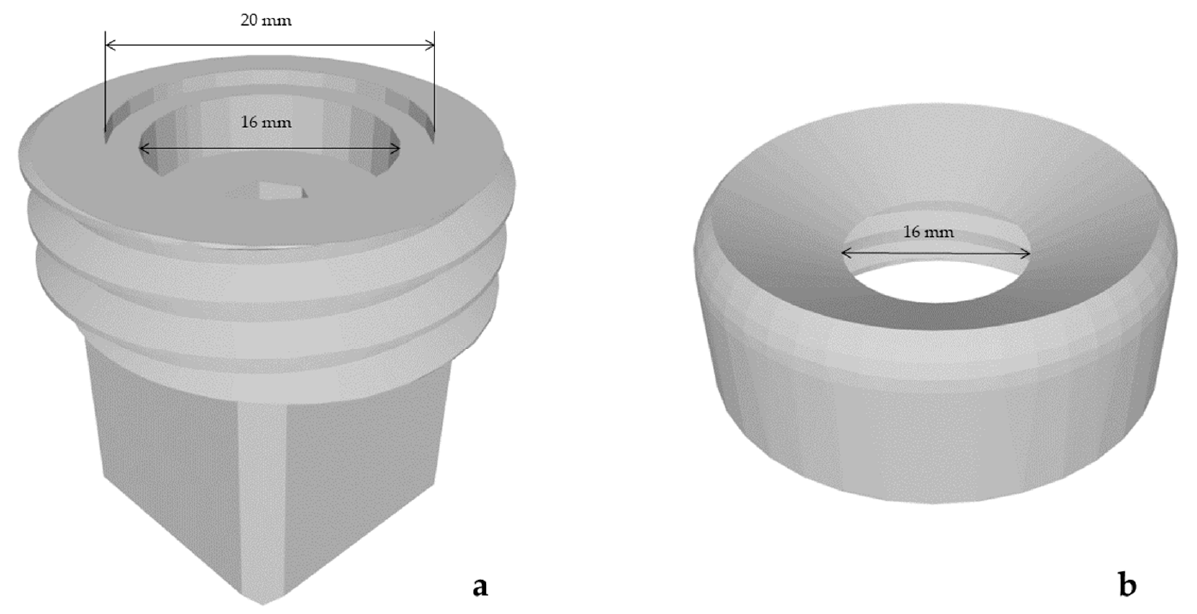
Figure 3. Set-up attachment for tests at an angle of 90 ◦ without prestress. The base of the attachment with the cubic adapter viewed in an angled perspective from the top ( a ). The lid of the attachment viewed angled from the top ( b ).